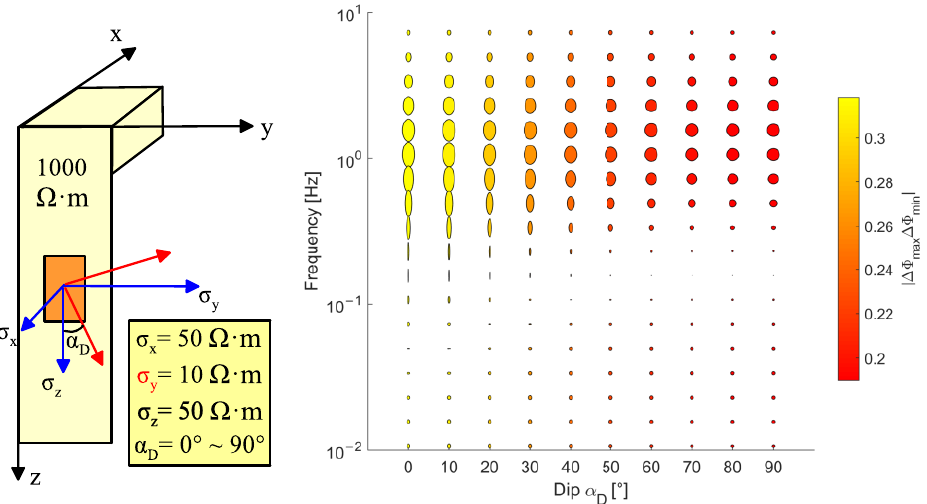
Figure 12. The fracture anisotropy model and the residual phase tensor for different dip angles in the conductivity y-axis.